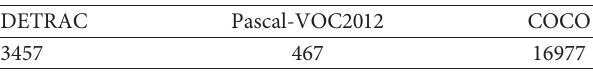
Figure 6: Nonlocal attention structure (refine). Table 1: The distribution of the dataset.